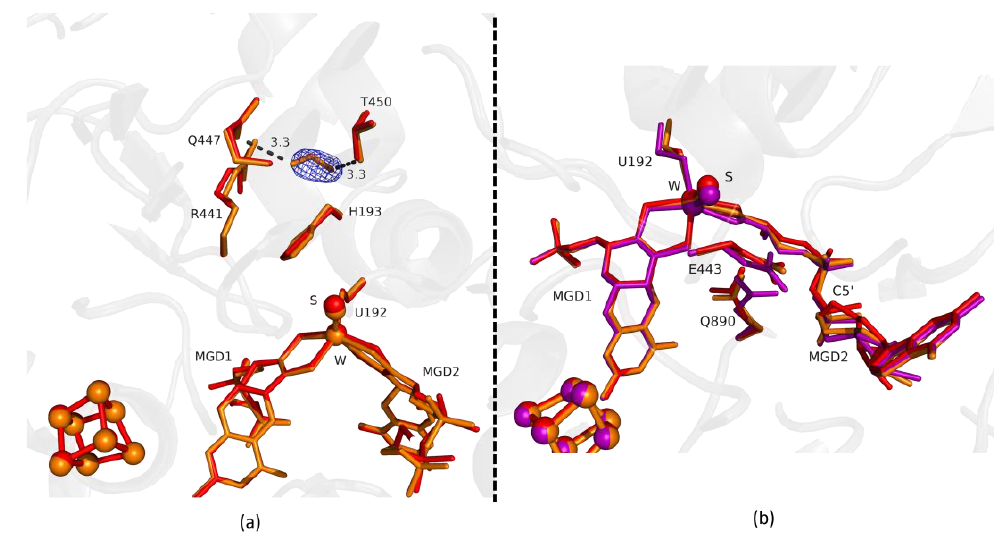
Figure 1. Superposition of Desulfovibrio vulgaris Formate dehydrogenase 1 ( Dv FdhAB) as-isolated (red), formate-soaked Fdh_1min structure (orange), and formate reduced (violet) (in b ) in two different orientations. ( a ) U192, H193, R441, Q447, T450 and the two Molybdopterin Guanine Dinucleotide (MGD) co-factors are shown as sticks, along with a formate molecule present in the formate tunnel of Fdh_1min. The 2fo- fc map is shown as a blue mesh, at 1.0 σ. The formate molecule is held by hydrogen bonds to side chains T450 Oγ and Q447 Oε (distance indicated in Å). ( b ) U192, E443, Q890 and the two MGD co-factors (note the C5 ′ atom of MGD2) are shown as sticks. Fdh_1.5min crystals diffracted to higher resolution, but a formate molecule could not